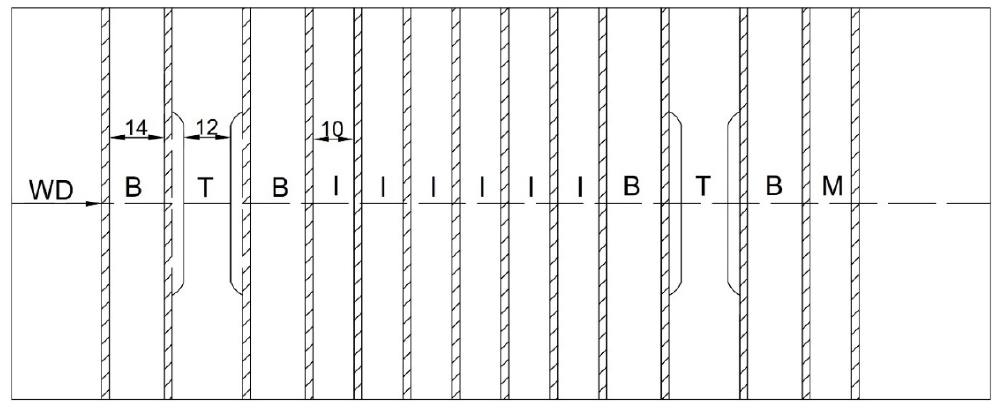
Figure 1. Specimens in a welded plate: M ‐ macro; T ‐ tensile testing; B ‐ bend testing; I ‐ impact testing, with indicated welding direction (WD) and specimen sizes, the thickness being kept as the plate itself. The dashed line indicates the position of the weld.